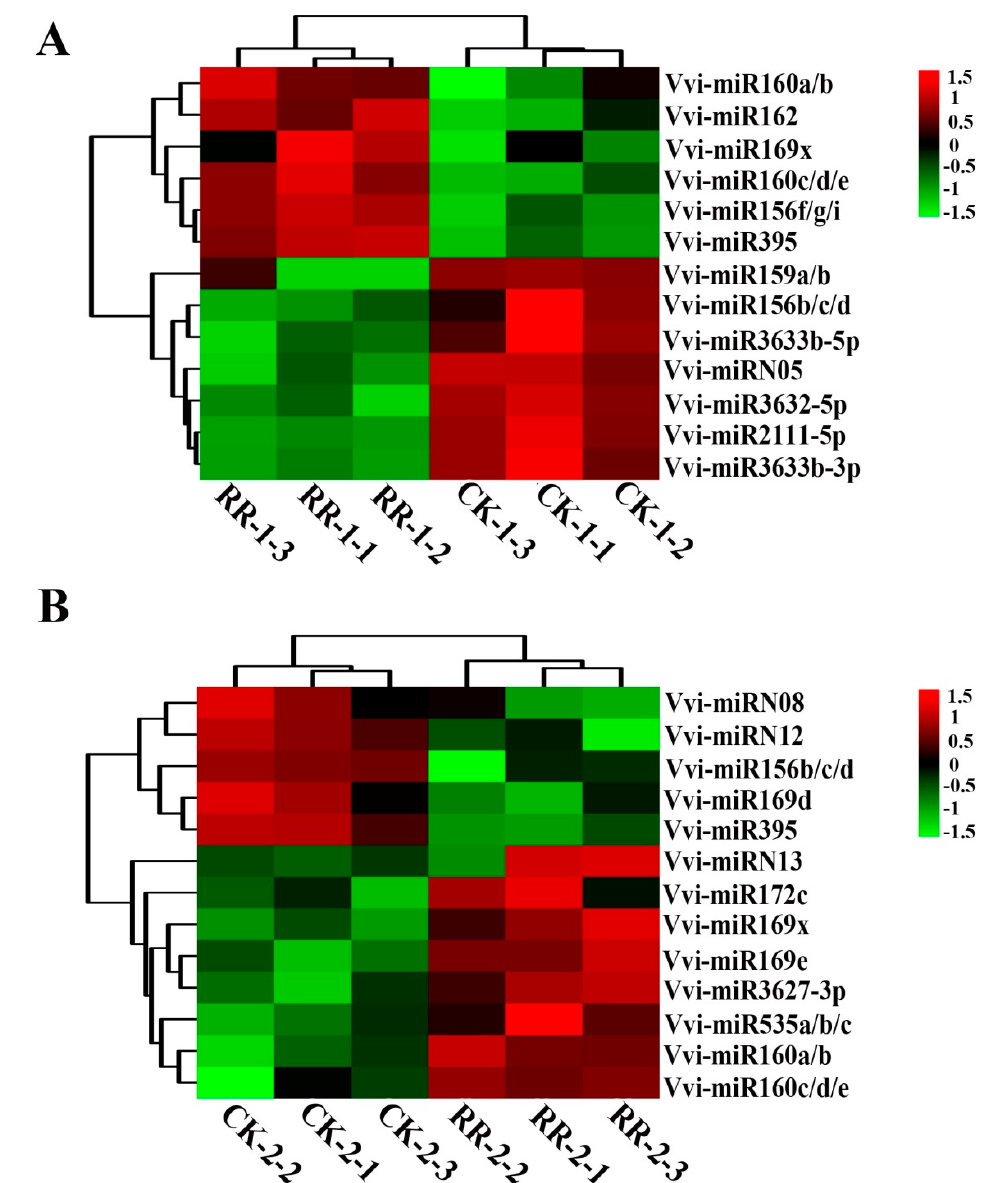
Figure 4. Heat maps of the normalized expression level (TPM) of differentially expressed miRNAs between RR and CK in the same period. ( A , B ) were from samples collected on 14 July 2017 and 9 August 2017, respectively. RR-1: fruits collected on 14 July 2017 grown under root restriction; CK-1: fruits collected on 14 July 2017 grown under non-root restriction; RR-2: fruits collected on 9 August 2017 grown under root restriction; CK-2: fruits collected on 9 August 2017 grown under non-root restriction.